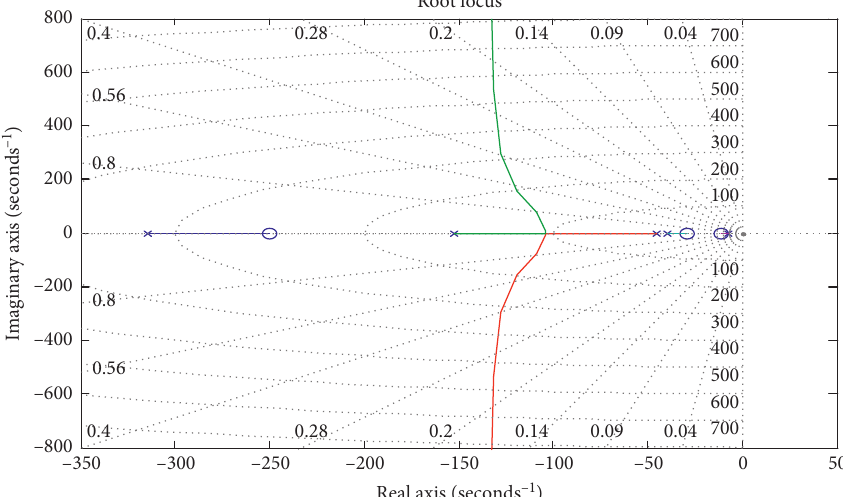
Figure 6: Root locus of the closed loop adaptive control system.